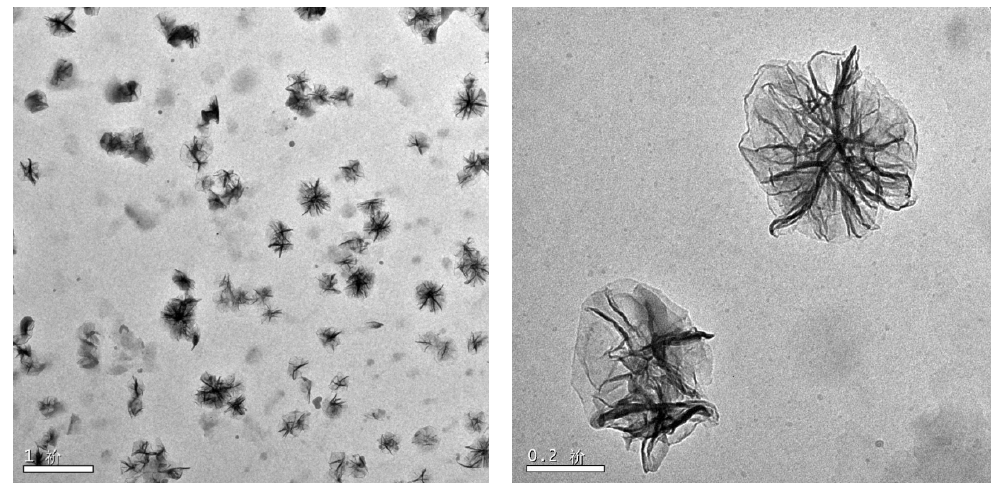
Figure 3: SEM micrographs of OMMT